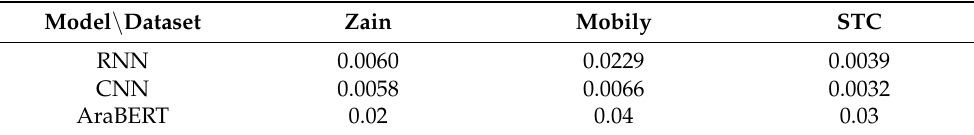
Table 2. Training Error Results obtained by CNN, RNN and AraBERT.